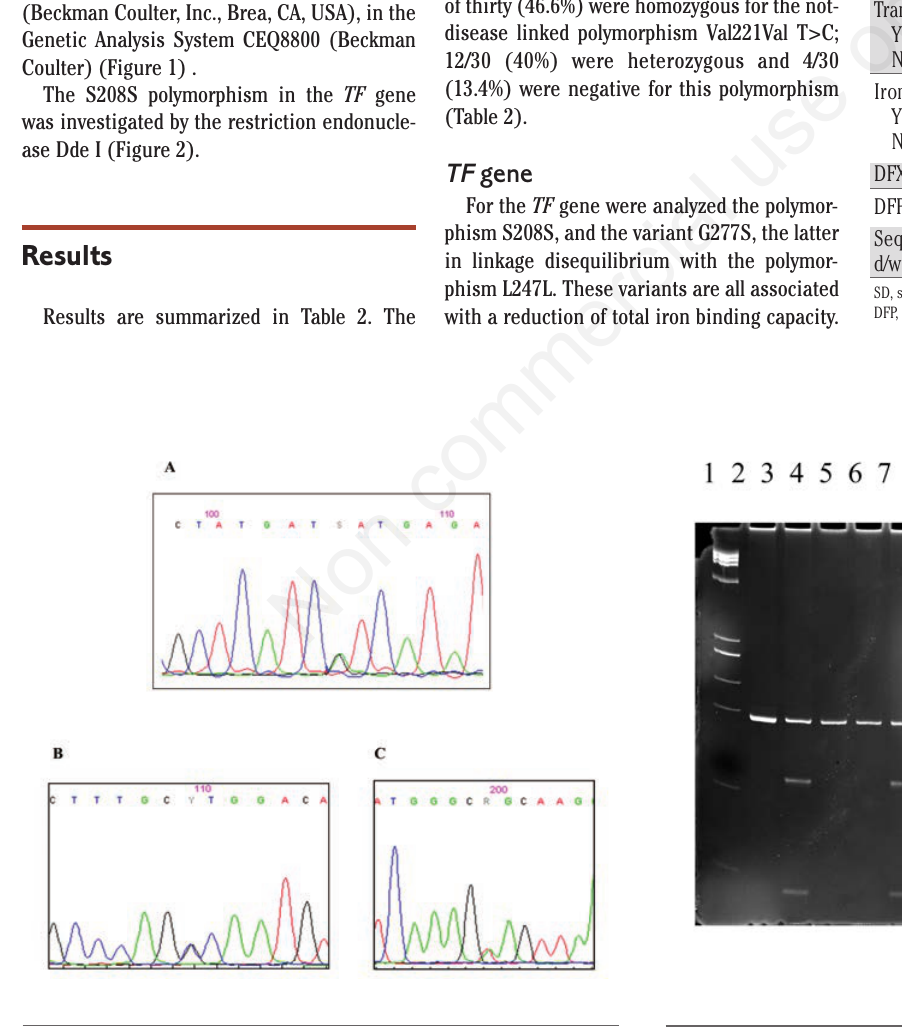
Figure 1. Direct gene sequencing. A) exon 2 of HFE gene: het- erozygous H63D; B) exon 7 of TF gene: heterozygous L247L; C) exon 7 of TF gene: heterozygous G277S.